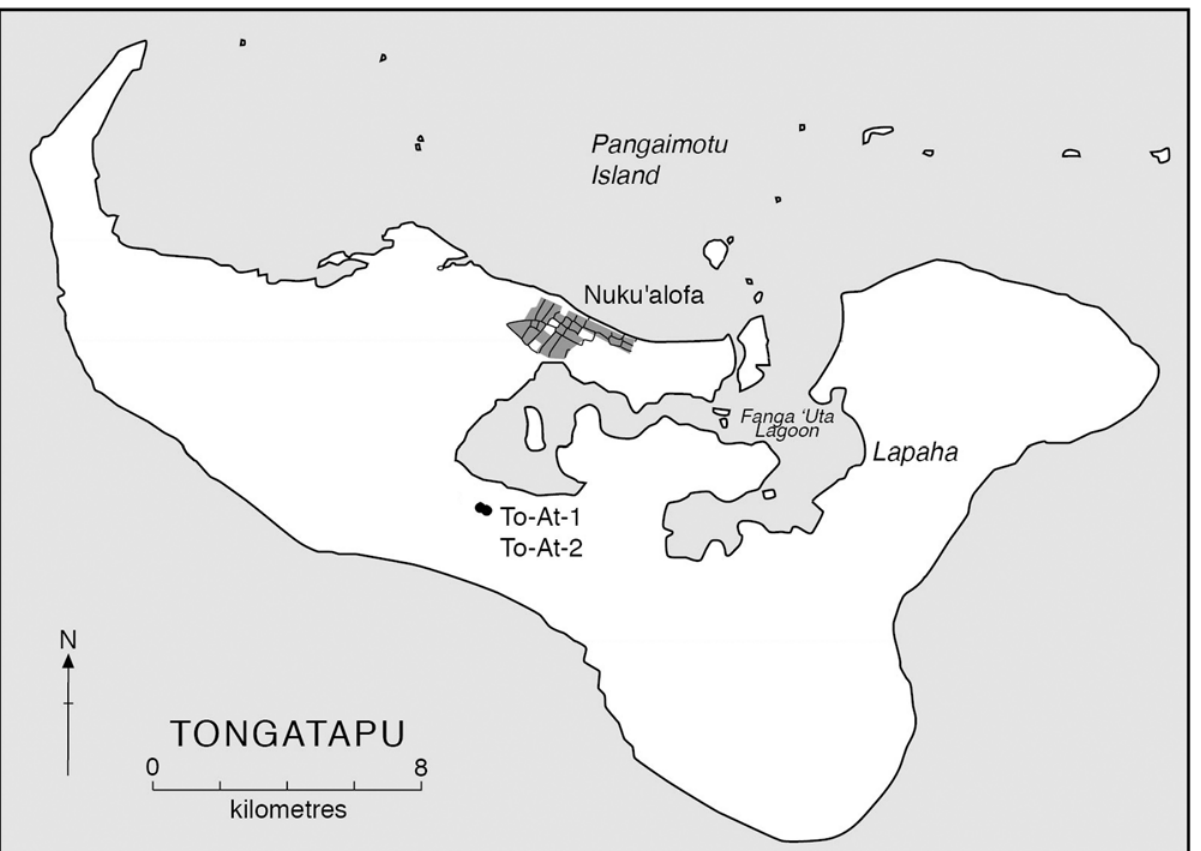
Fig 1. Map of Tongatapu. `Atele burial mounds (To-At-1 and To-At-2) labeled. Image courtesy of Geoffrey Clark.